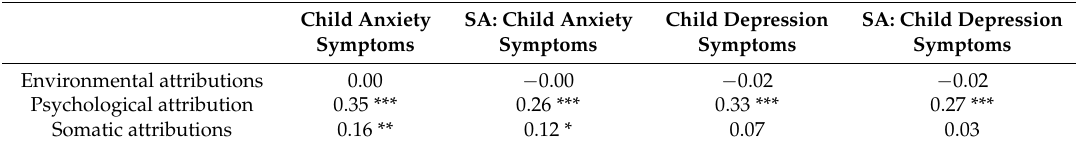
Table 2. Comparison of correlations with main and sensitivity